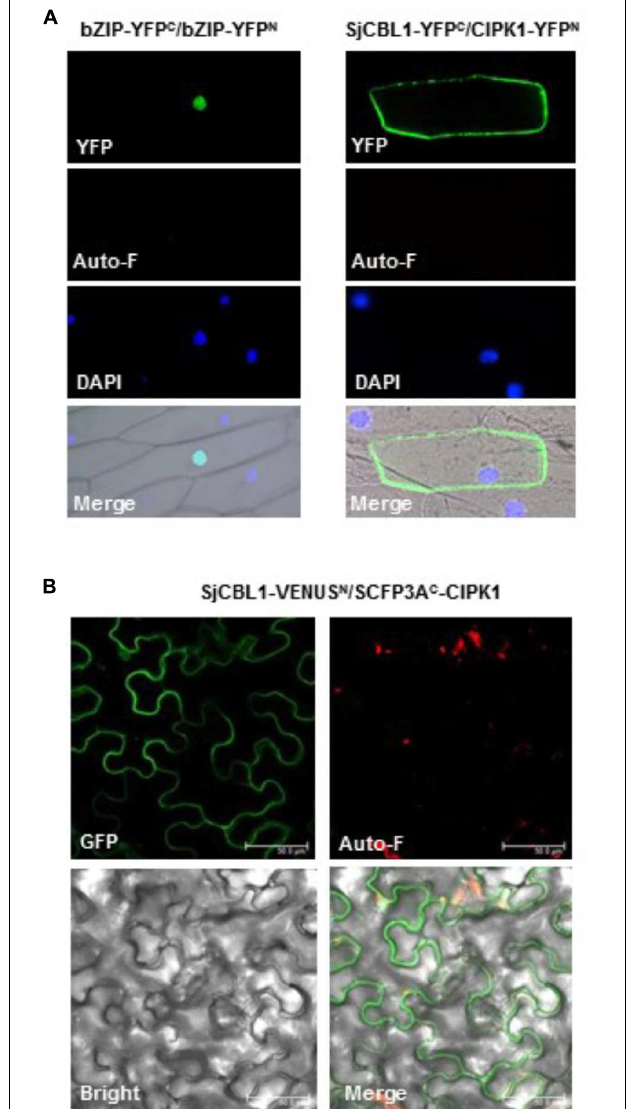
FIGURE 8 | In vivo interaction between SjCBL1 and CIPK1. (A) Bimolecular fluorescence complementation (BiFC) analysis in onion epidermal cells. The indicated plasmids were introduced into the plant cells via the biolistic particle-delivery system. The bZIP63-YFP N and bZIP63-YFP C plasmids were used as a positive control. Following 18-h incubation at 23 ◦ C, the onion cells were analyzed with a fluorescence microscope. YFP and Auto-F indicate images of YFP fluorescence and auto-fluorescence, respectively. DAPI shows nuclei visualized by DAPI staining. The merged images are shown in